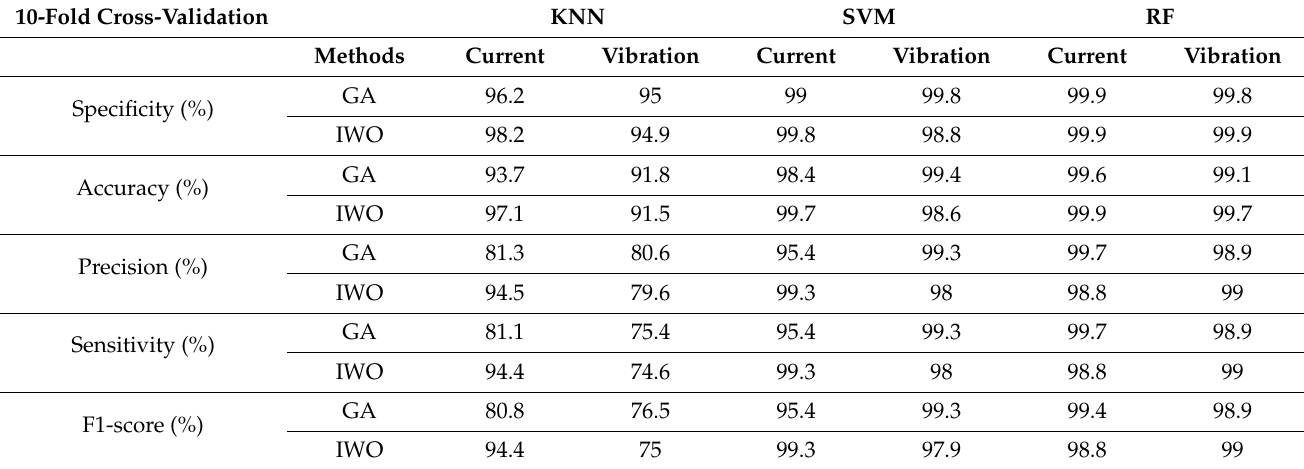
Table 9. Comparison between Invasive Weed Optimization and Genetic